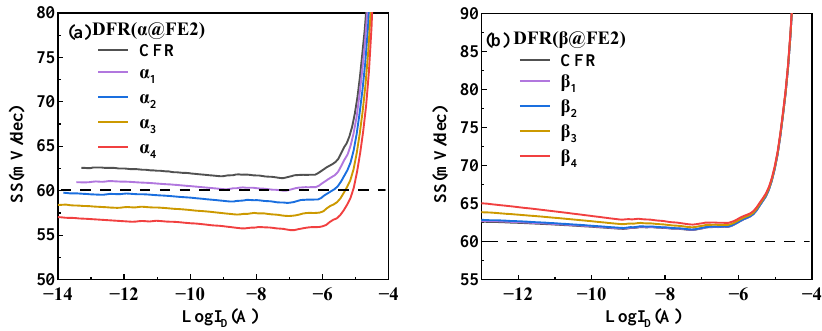
Figure 11. Subthreshold swing versus current curves for the DFR-NCFET and CFR-NCFET with ( a ) variable α in FE2 region, ( b ) variable β in FE2 region.